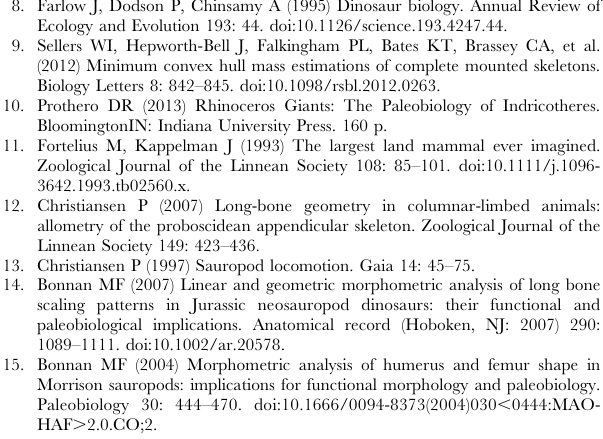
Table S1 Mammal specimens utilized in the study. Table S2 Archosaur specimens utilized in the